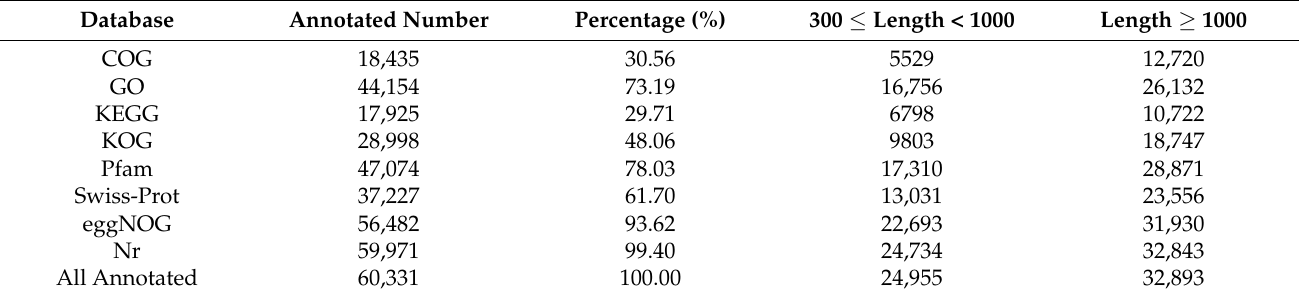
Table 3. Summary of gene annotation